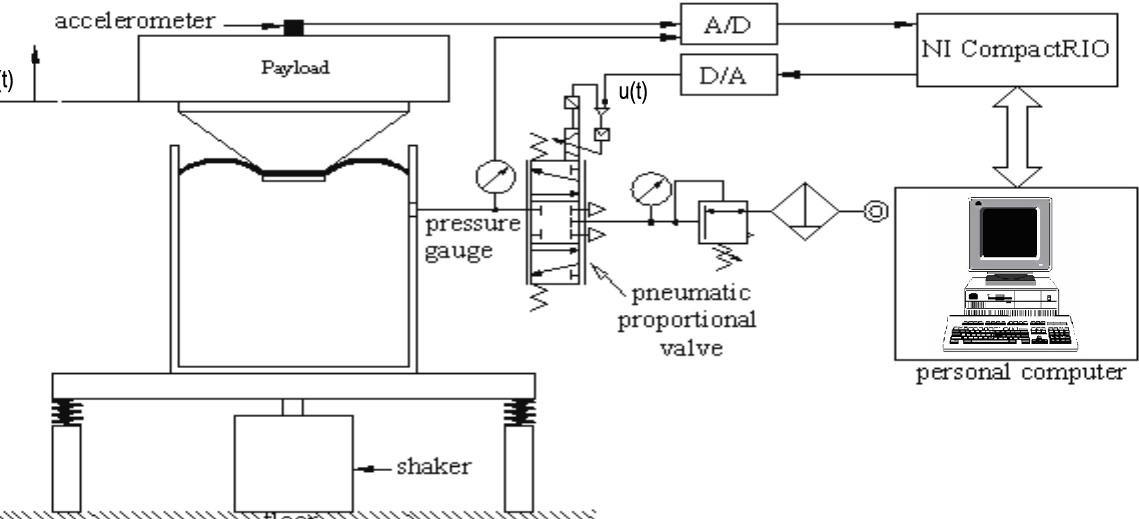
Figure 1. The schematic diagram of the experimental set